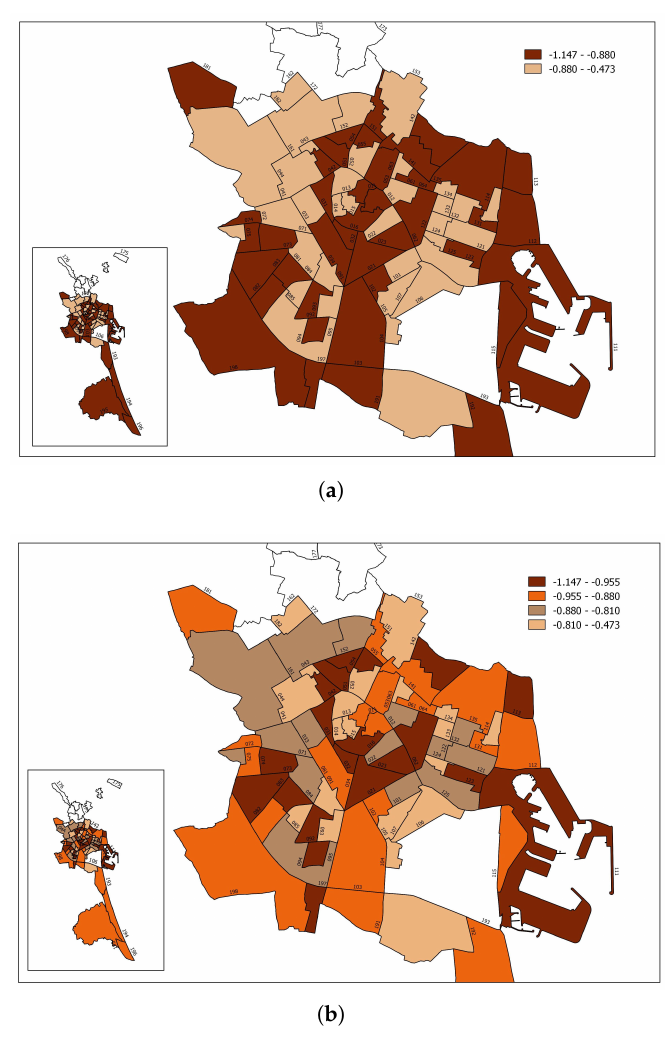
Figure 3. Elasticity by neighbourhoods for all periods. ( a ) Two ranges. ( b ) Four ranges. Additionally, an estimation of the covariance matrices measuring how the total vari- ability was distributed across neighbourhoods, periods and observations was obtained: In the variances–covariances of the random effects for neighbourhoods (Table 2), the covari- ances between the random terms of the intercept and the slope were negative. Thus, for the average price, a given neighbourhood had a smaller value of the random term of the slope if the random term in the intercept was larger (Figure 4). Table 2. Covariance matrix for neighbourhood and